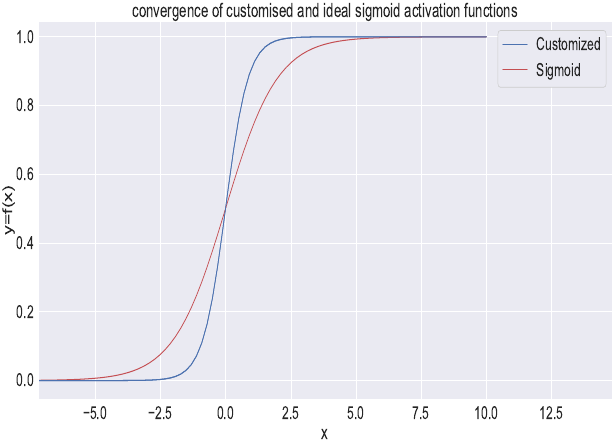
Figure 7. Convergence of the proposed (customized) activation function and Sigmoid function. For the training of the siamese network, two images, each of size 112 × 112 pixels, are applied parallelly; the CNN extract the features from the image and represents them in the form of a feature vector. The feature vector is then used to calculate the euclidean distance. This system uses a contrastive loss function to calculate the error and train the model. The loss function trains the network such that when beats belonging to the same person are applied, they will have less Euclidean distance as compared to beats of different persons. The detailed layers and sizes of the Siamese network are shown in Table